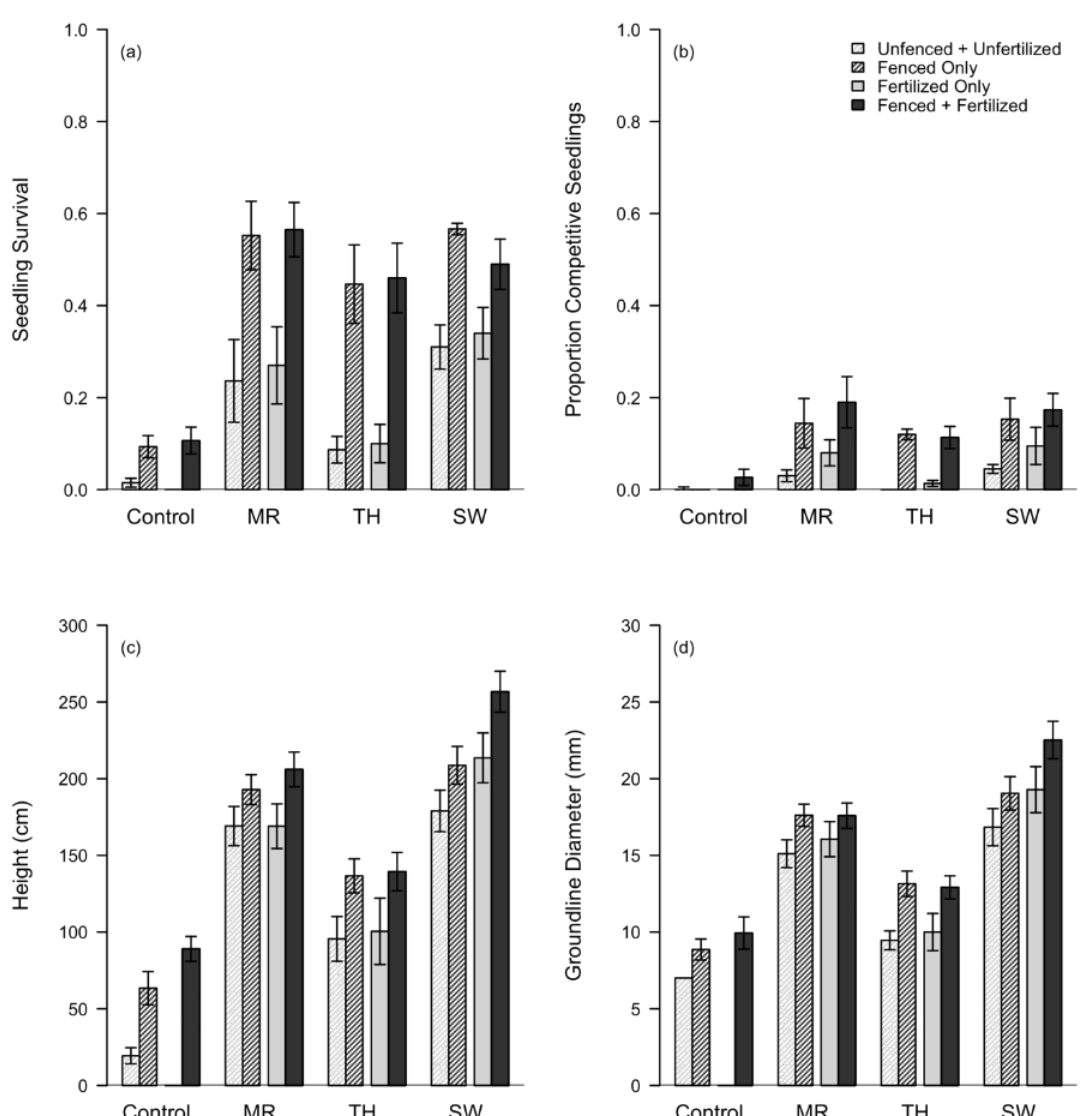
Figure 3. Mean ( ± SE) survival ( a ), competitiveness ( b ), height ( c ), and ground-line diameter ( d ) of underplanted northern red oak ( Quercus rubra L.) seedlings ten growing seasons after planting with different silvicultural, fencing, and fertilization treatments. MR midstory removal; TH light crown thinning; SW shelterwood establishment cut. Table 3. Predicted probabilities of seedling survival and competitiveness generated from the most parsimonious mixed-effects logistic regression models for each response after ten years. Probability of competitiveness is relative to the number of seedlings initially planted. Treatments are listed in descending order by predicted probability of competitiveness. MR midstory removal; TH thinning; SW shelterwood.